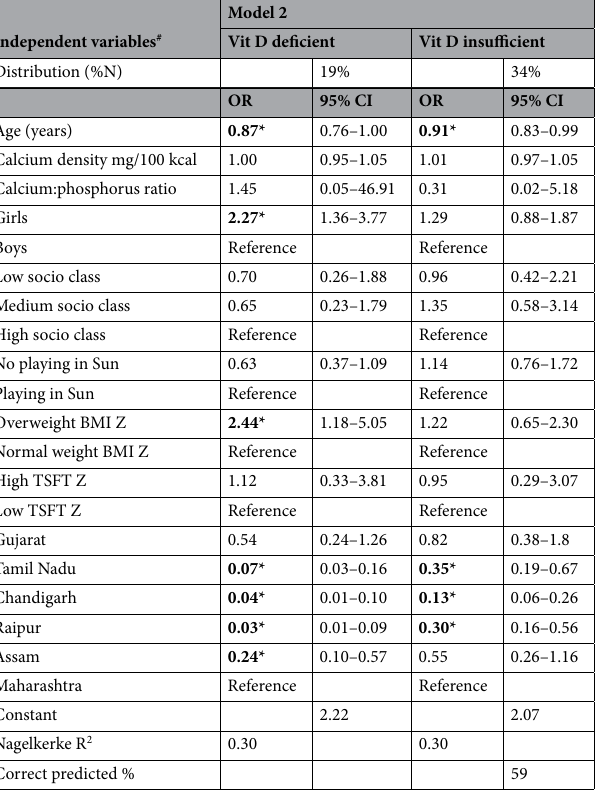
Table 5. Multinomial logistic regression to determine predictors of vitamin D status in subset study population, n = 669 (Model 2: demographic, anthropometric, body composition and lifestyle parameters and state of residence). Significant values are in [bold]. TSFT triceps skin fold thickness, Z Z-scores. Level of Significance—* p < 0.05. # Variables are presented as OR (95% CI).